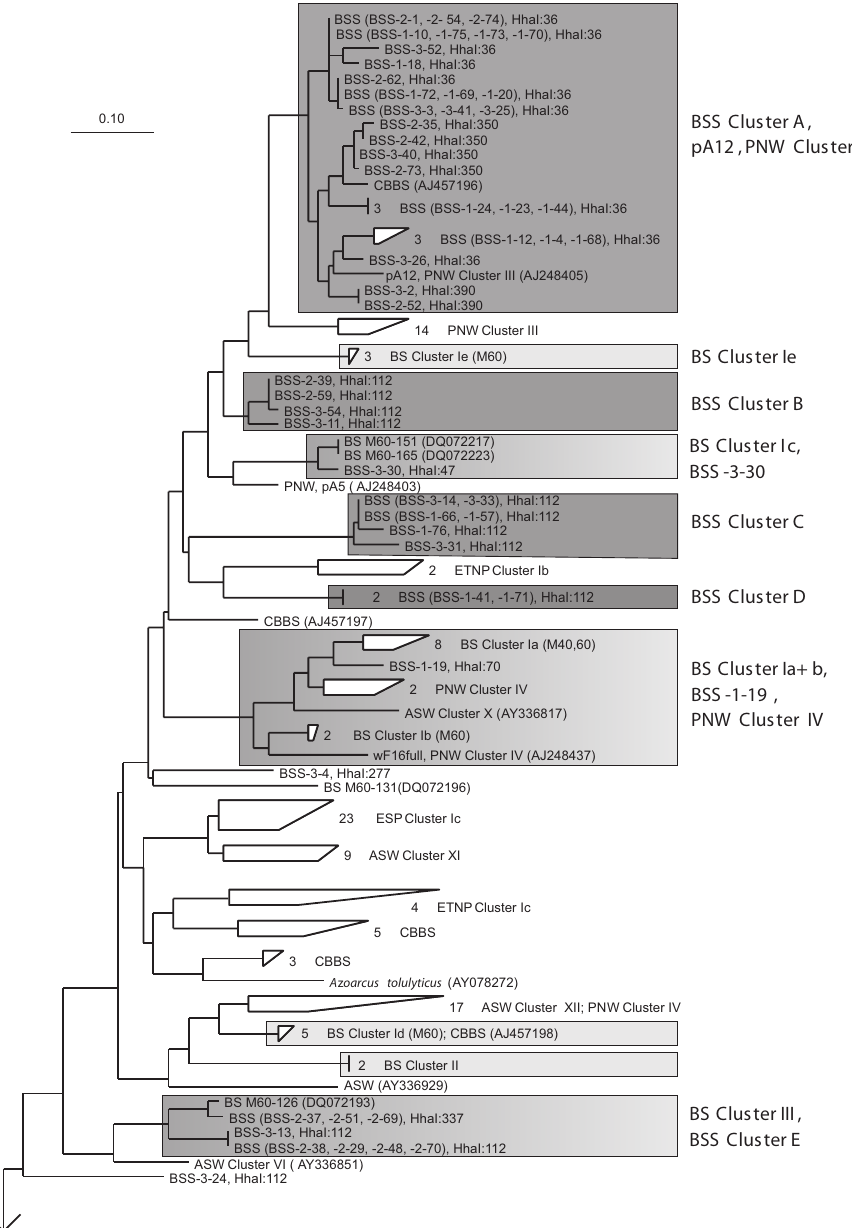
Fig. 5. Phylogenetic tree of nirS sequences clustering in marine Cluster I. nirS sequences from sediment samples from the Baltic Sea were labelled with BSS. Clones were labelled with numbers to indicate from which depth of the sediment sequences were retrieved (1, 0 to 5mm; 2, 5 to 12mm; 3, 12 to 30mm) and a second number for the respective clone . nirS clusters from Baltic Sea sediments were labelled with A to F. The number after the polygon indicates the number of clones of a given cluster. The number after the restriction enzyme name ( Hha I) indicates the size of the terminal restriction fragment. ASW, Arabian Sea water column; BS, Baltic Sea water column; CBBS, cyanobacterial bloom Baltic Sea; ESP, eastern South Pacific sediment; ETNP, eastern tropical North Pacific sediment; PNW, Pacific Northwest